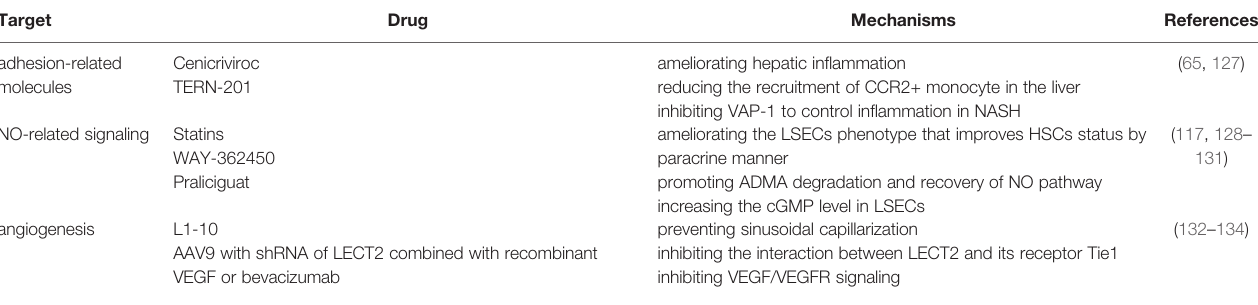
TABLE 1 | Therapeutic drugs related to crosstalk between LSECs and other sinusoidal cells involved in this paper.